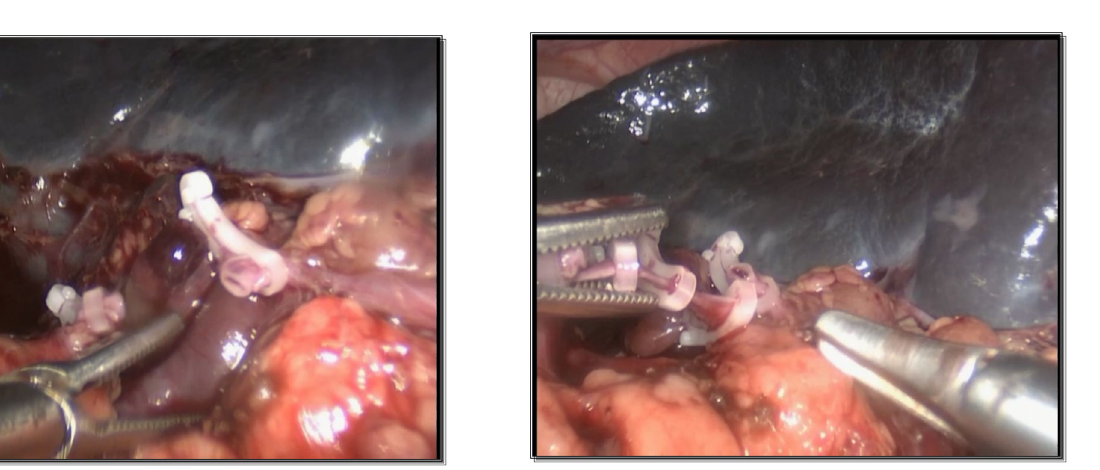
Fig. 4 The artery was cut between 2 clips proximal and 1 clip distal using scissor